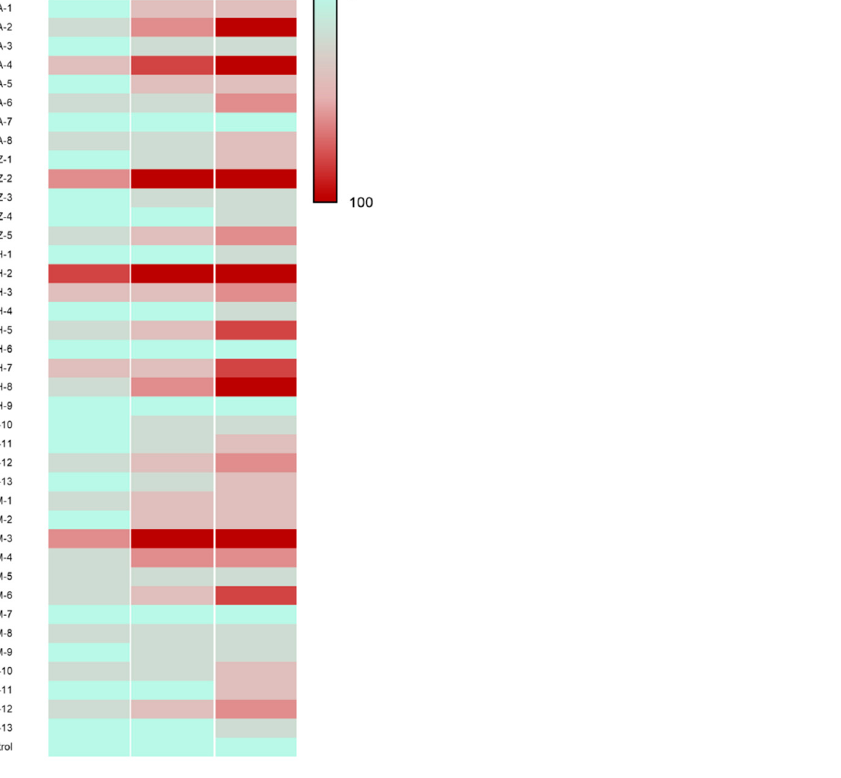
Figure 2. Insect killing heatmap of 39 insect associated fungal isolates against S. litura larvae at 3, 6- and 10-days post infection (d.p.i.). Isolates were obtained using the G. mellonella baiting technique and were isolated from different regions in Nile Delta north of Egypt.